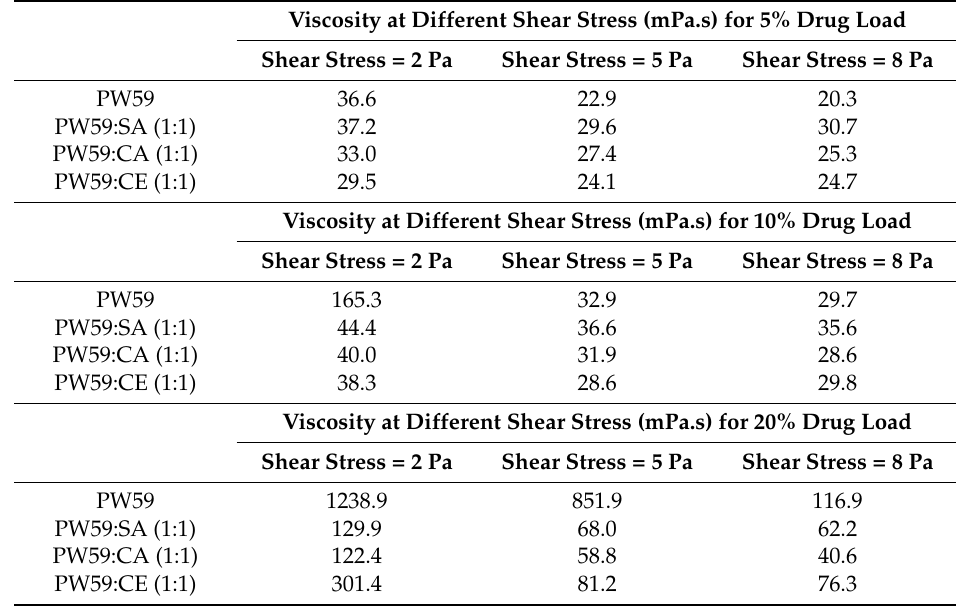
Figure 5. Rheograms of ( A ) PW59; ( B ) PW59:SA (1:1); ( C ) PW59:CA (1:1); ( D ) PW59:CE (1:1) systems containing 0% ( ); 5% ( (cid:4) ); 10% ( (cid:78) ); 20% w / w ( (cid:7) ) paracetamol ( n = 3). Note: Although this is not clearly seen in the rheograms, the drug-loaded blends comprising PW59 and SA, CA, or CE exhibited pseudoplastic flow as the rheometer readings showed that the samples moved as soon as a stress was applied. Table 1. Viscosity at different shear stress for formulations containing various drug loads ( n =